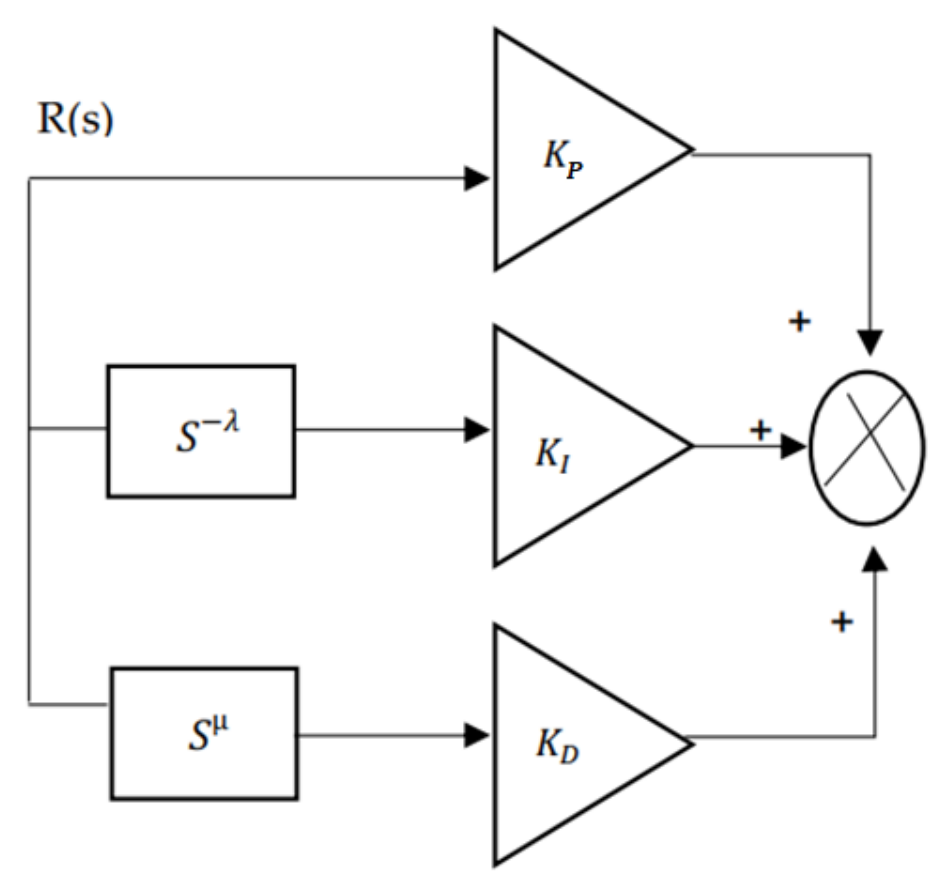
Figure 6. Block digram of a fractional-order PID controller.